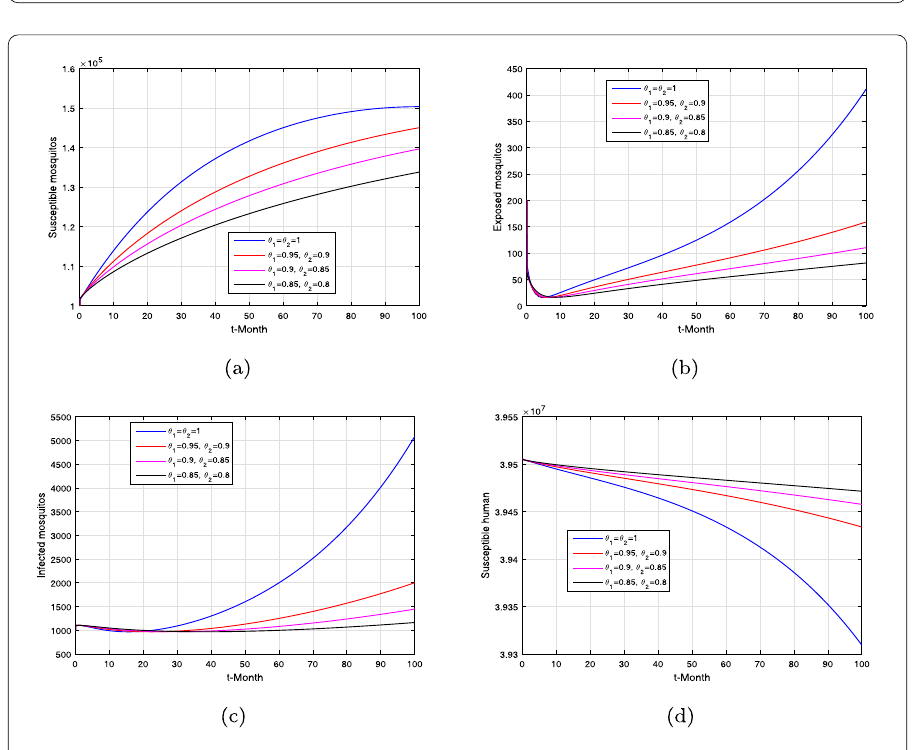
Figure 8 Simulation of the fractal-fractional model (10) when θ 1 = 1,0.95,0.9,0.85 and fractal order θ 2 = 1,0.9,0.85,0.8 where ( a ) susceptible mosquitos, ( b ) exposed mosquitos, ( c ) infected mosquitos, ( d ) susceptible